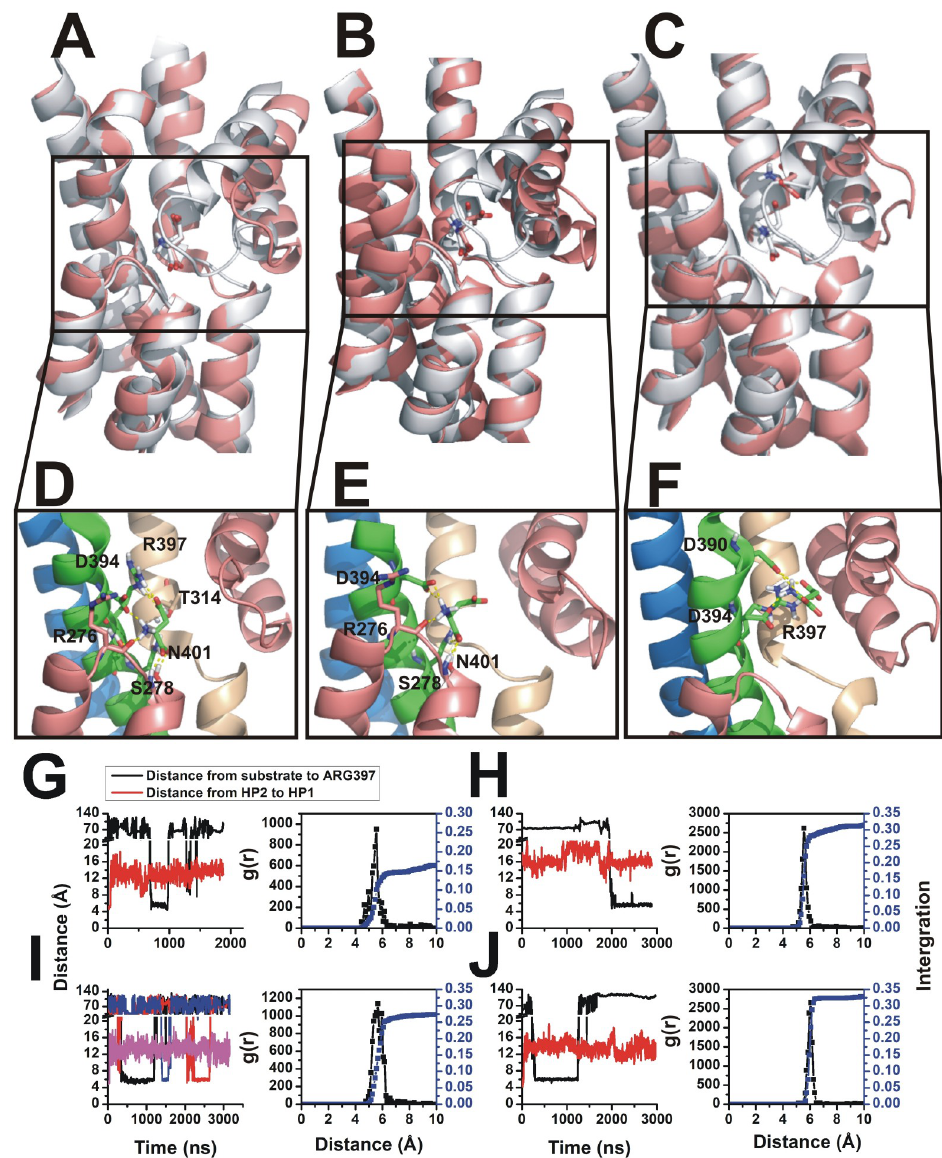
Fig 4. Coordination states during spontaneous binding to Glt ph at high aspartate concentration. In MD spontaneous binding simulations at high aspartate concentration (~0.1 M), three major binding states are compared with the crystal structure were illustrate in (A) to (C). Aspartate coordination is shown magnified for each state in (D) to (E), respectively. The simulation results are illustrated in pink, and for comparison, the structure from the crystal structure (2nwx) is shown in grey. (A) and (B) are syn and anti -conformations of aspartate located in the binding pocket. (C) shows the intermediate state which binds to the same residues as in Fig 2D. Eight independent simulations were analyzed, and the time evolution results are shown from (G) to (J). Distance calculations are based on the same reference residues shown in Fig 2. Aspartate distance from the binding site reference residue (black) and HP2-HP1 distance (red) are shown in each panel. Radial distribution function analysis results are shown at the right of each trajectory. The different colors in (G) indicate different aspartate molecules binding and dissociating.